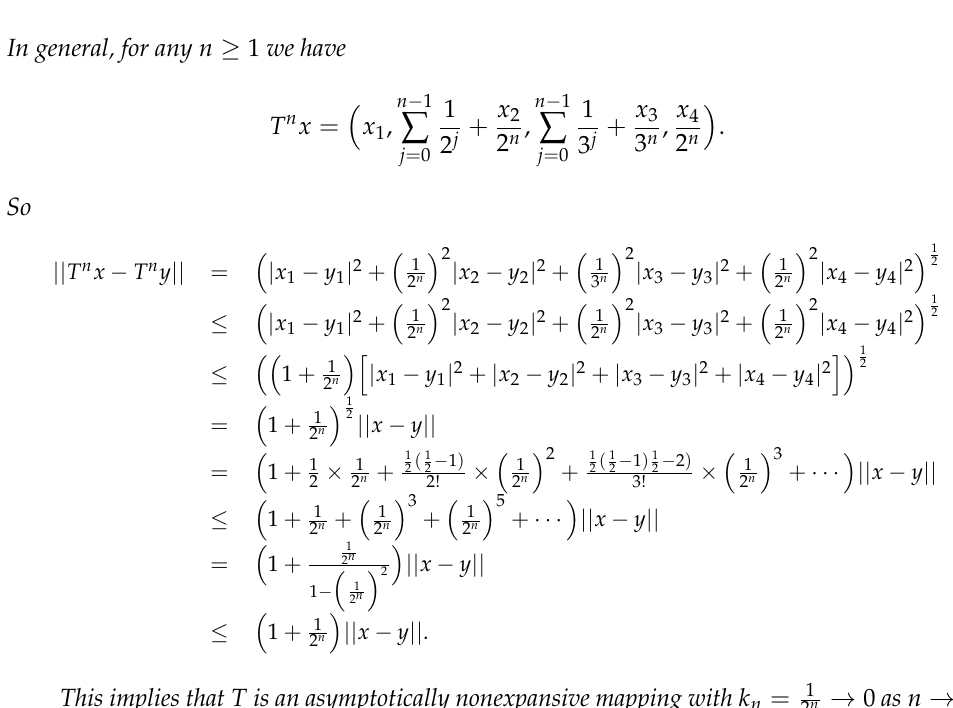
, ρ n = 2 n , σ n = 2 5 n + 8